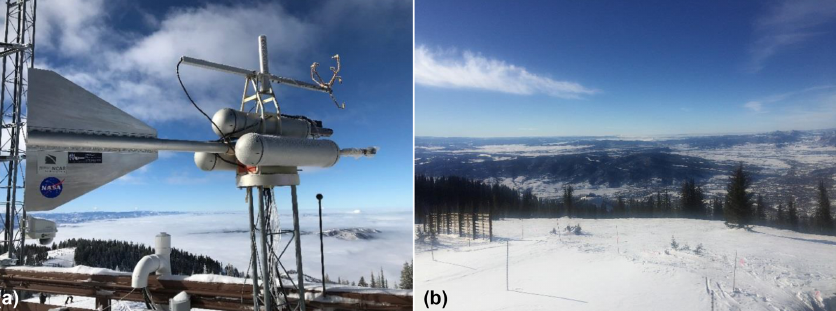
Figure 1. Recent picture of SPL probe stand with FSSP-100 in the foreground, Cloud Imaging Probe (CIP) in the background, and sonic anemometer on top (a) ; view facing west over the railing (b)